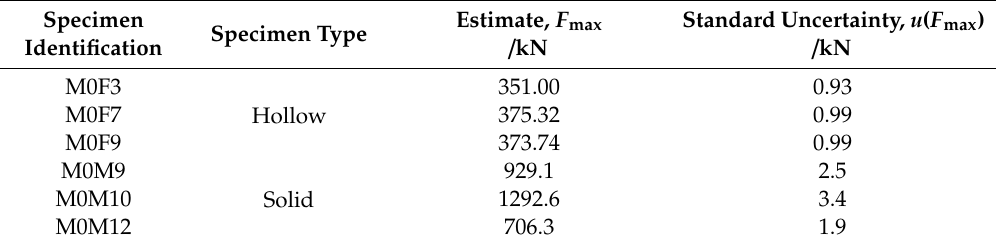
Table A3. Maximum load force measurements in tested masonry specimens.